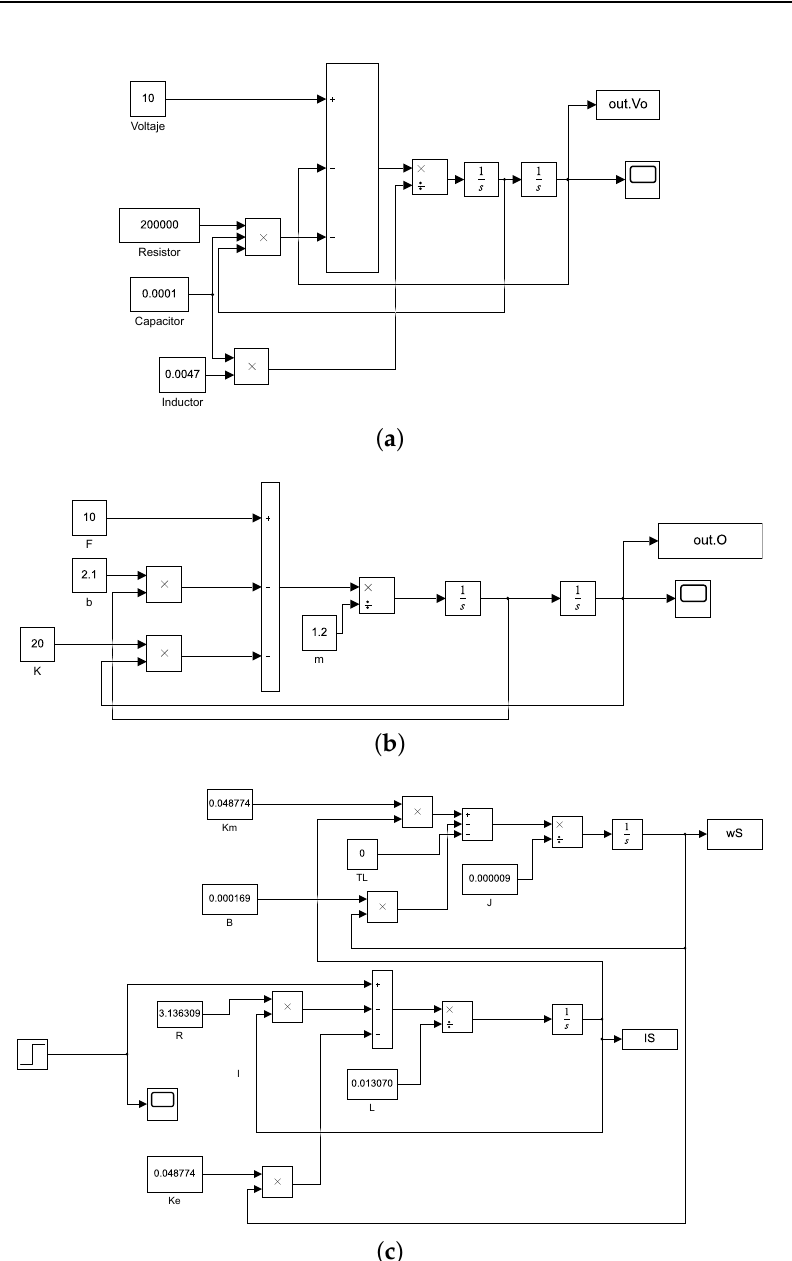
Figure 8. Simulations used for generating the step response signal. ( a ) Simulation for step response of RLC circuit; ( b ) Simulation for step response of mass-spring-damper system; ( c ) Simulation for step response of electromechanical